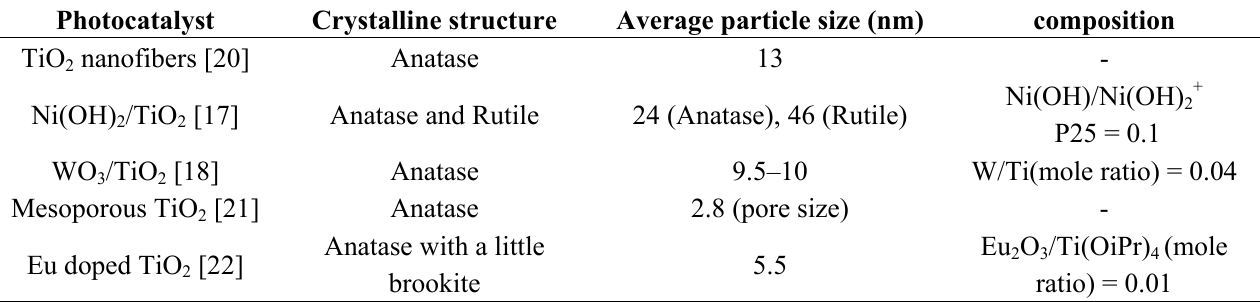
Table 2. Physical properties of the synthesized